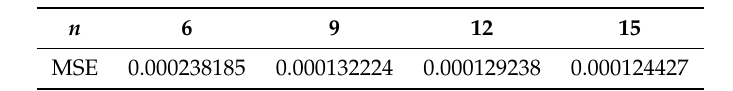
Table 7. n selection for PCAR.